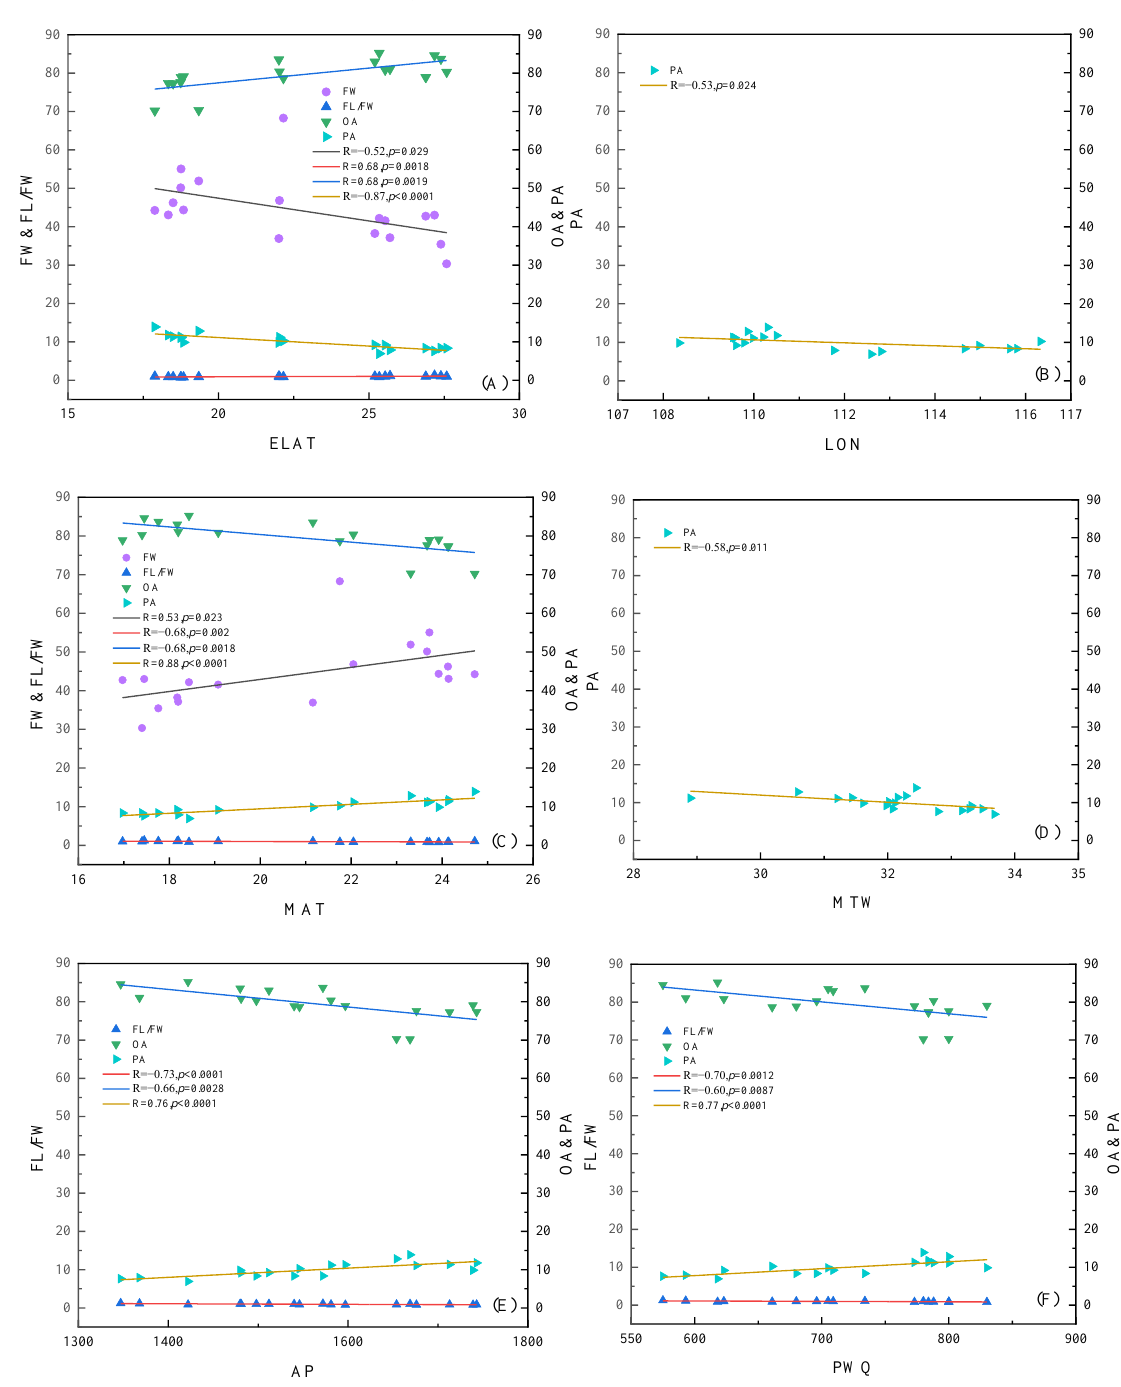
Figure 3. Relationship between fruit width (FW), fruit length (FL), FL/FW ratio, oleic acid (OA), linoleic acid (LOA), linolenic acid (LNA), palmitic acid (PA), and stearic acid (SA) with geographic and climatic factors in 18 populations of Camellia oleifera . AP, annual precipitation; ELAT, equivalent latitude; LON, longitude; MAT, annual mean air temperature; MTW, maximum temperature of warmest month; PWQ, precipitation of wettest quarter.